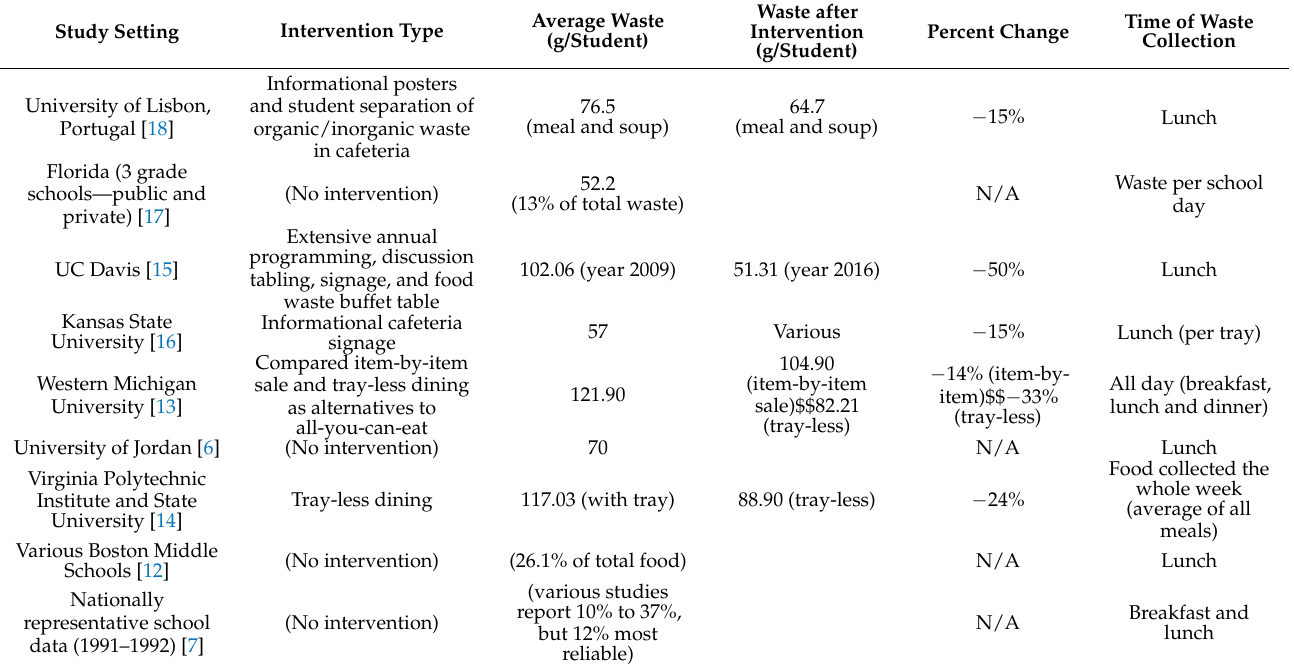
Table 1. Food waste per student as reported from various cafeteria food waste studies. Studies listed from most recent to oldest. The table presents the average waste per student per meal as reported in various school-based food waste studies. When an intervention was conducted, it is summarized along with the initial weights, final weights, percent change, and meal